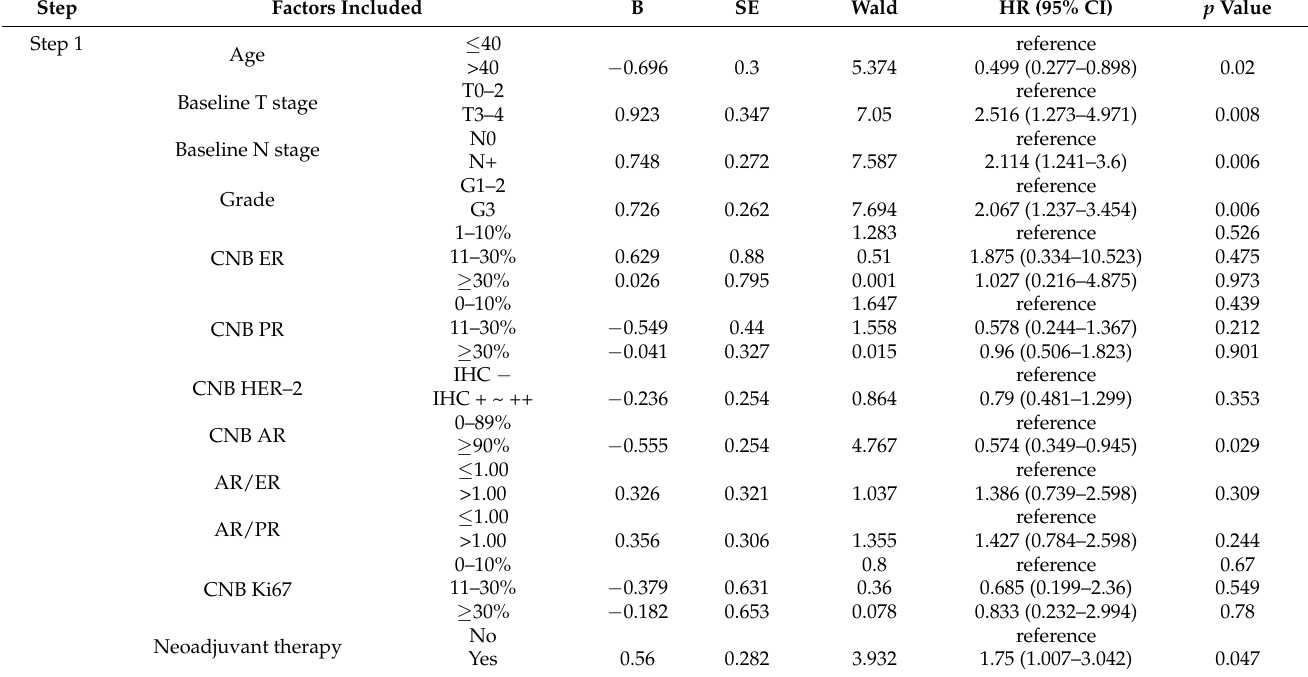
Table 3. Multivariate analysis of DFS in the luminal B (HER–2 negative) BC study